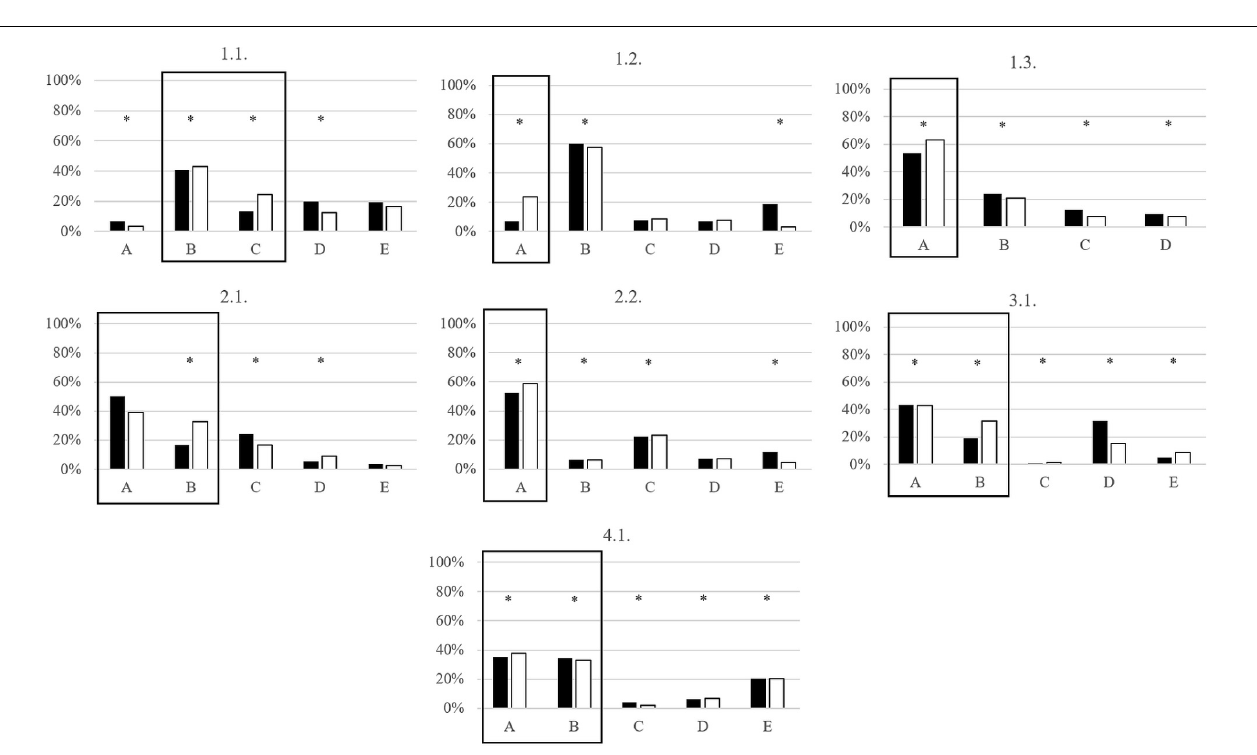
FIGURE 1 | Total scores for each type of questionnaire (Middle line – median; box lower and upper limits – 1st and 3rd quantiles; whisker values – 1.5 times the interquartile range from the top (or bottom) of the box to the furthest datum; points – outliers).